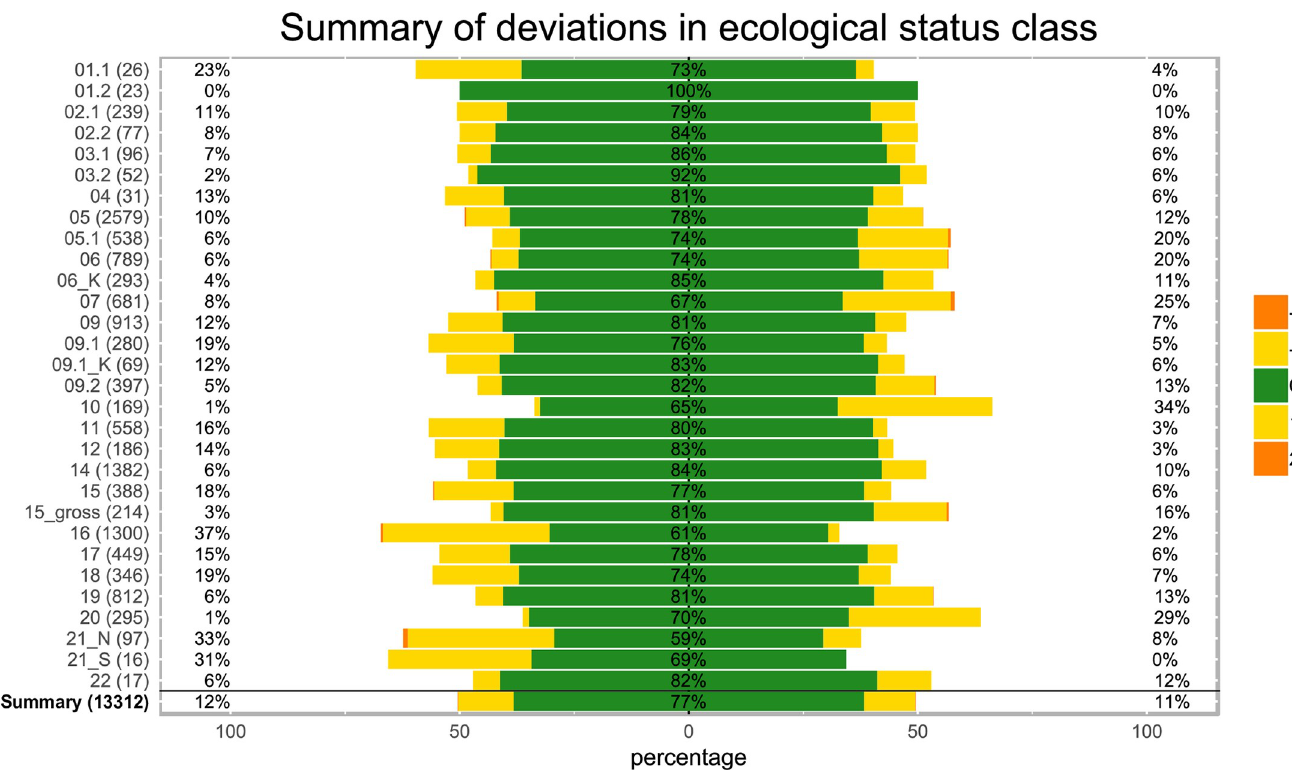
PLOS ONE | https://doi.org/10.1371/journal.pone.0226547 December23,